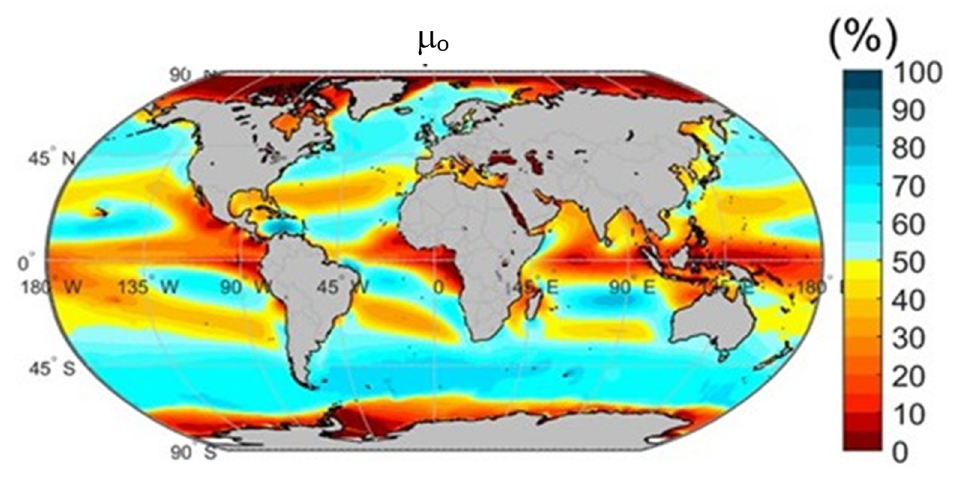
Figure 6. Global distribution of the annual mean operability.